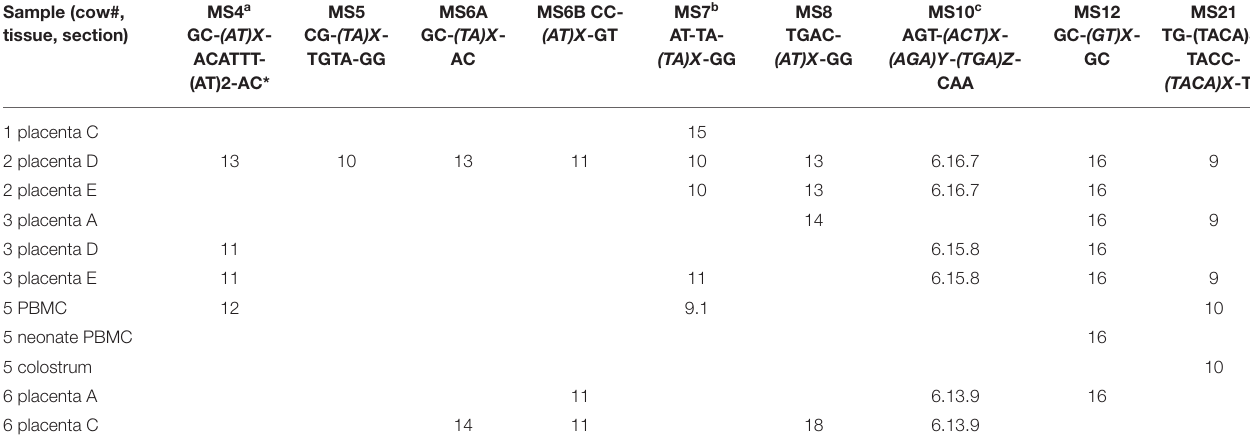
TABLE 2 | Genotypes of Neospora caninum from placenta, colostrum, and PBMC of 5 cows and PBMC of one neonate belonging to the positive pregnant group ( + Preg). Sample (cow#, tissue,